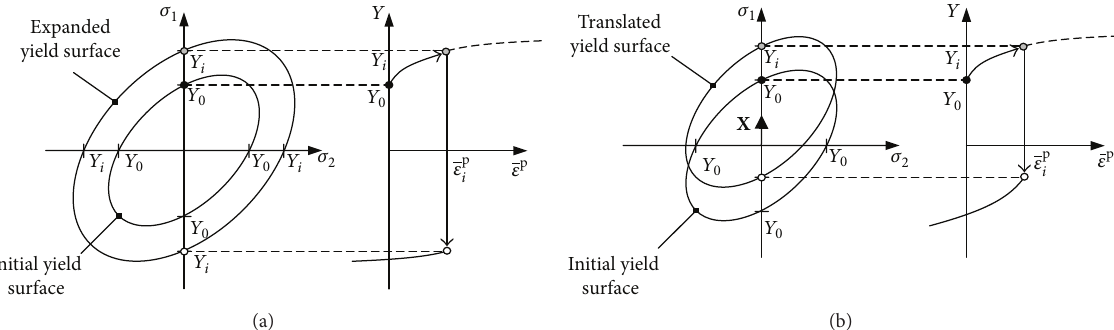
Figure 1: Representation of the plastic behaviour of materials in tension-compression. The left side shows generic yield surfaces in the plane ( 𝜎 1 ; 𝜎 2 ) and the right side shows the corresponding hardening law: (a) isotropic hardening and (b) kinematic hardening. See text for details. Adapted from